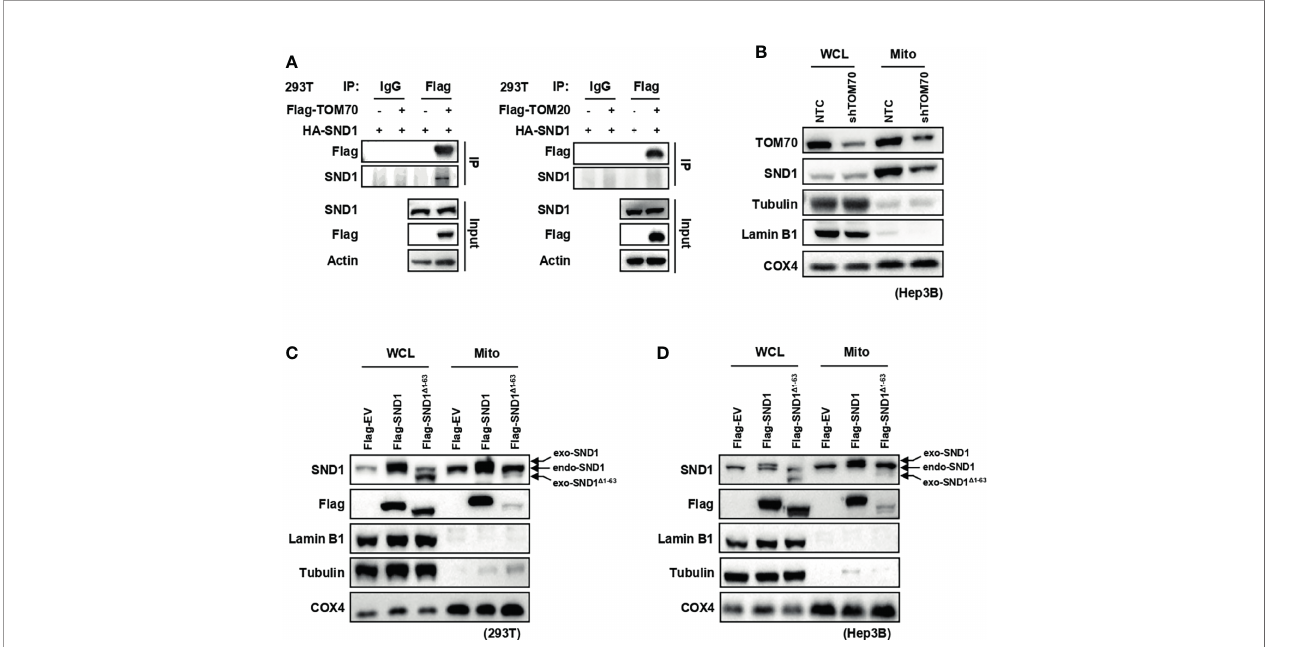
mitochondrial fraction,